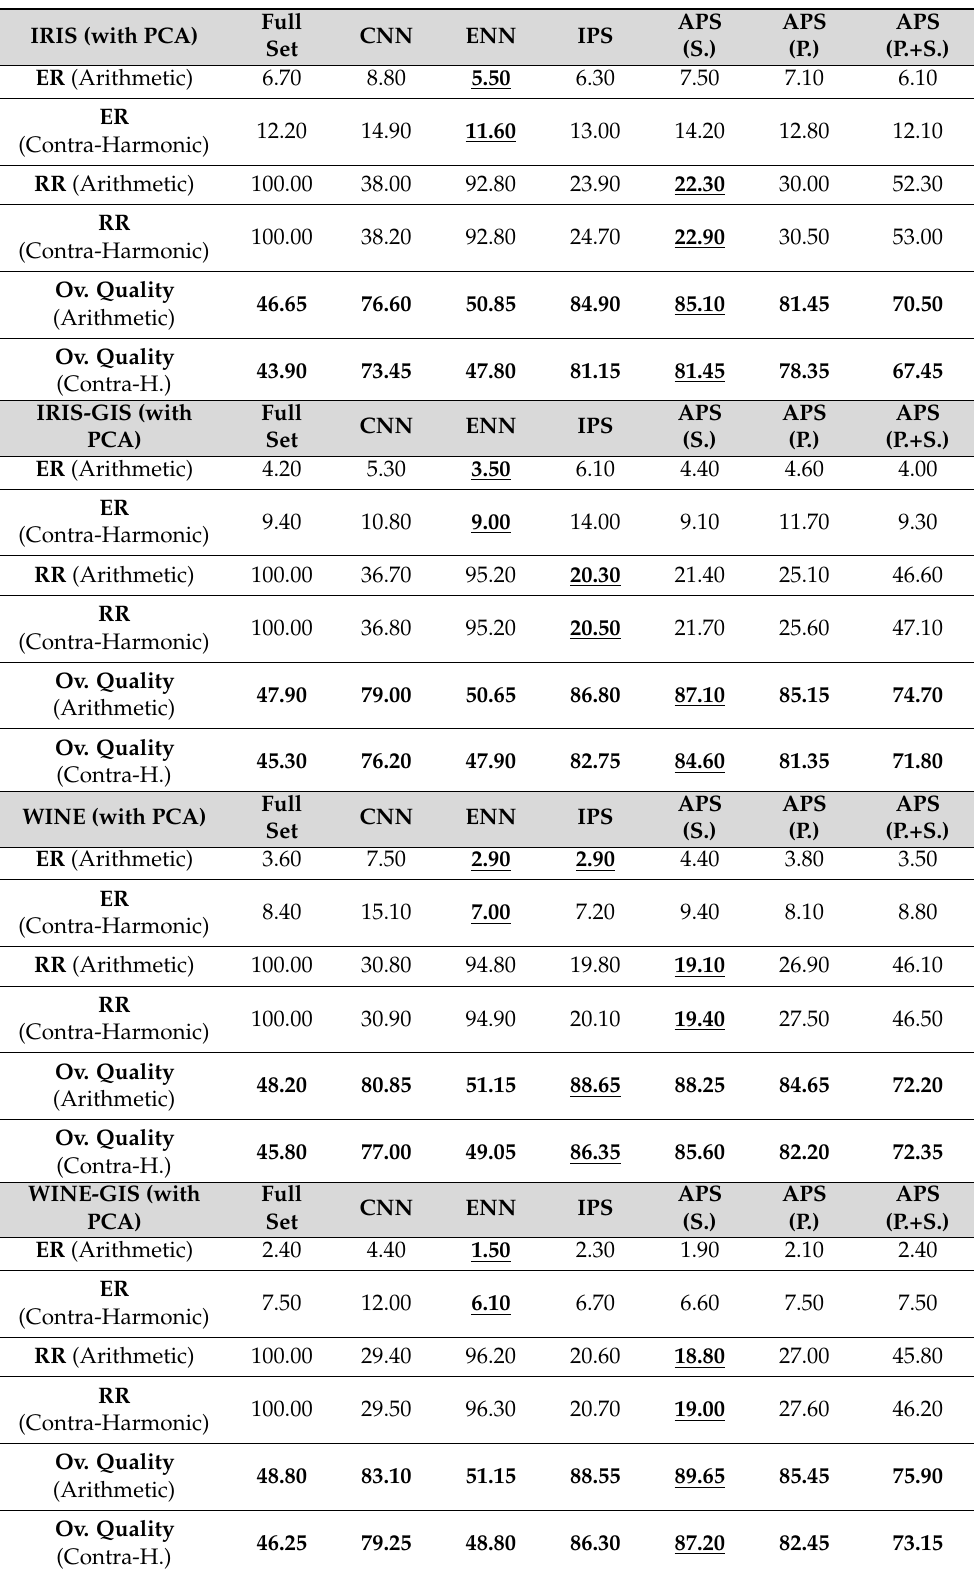
Table 8. Results of the experiments with the Iris vs. IRIS-GIS datasets and the Wine vs. WINE- GIS